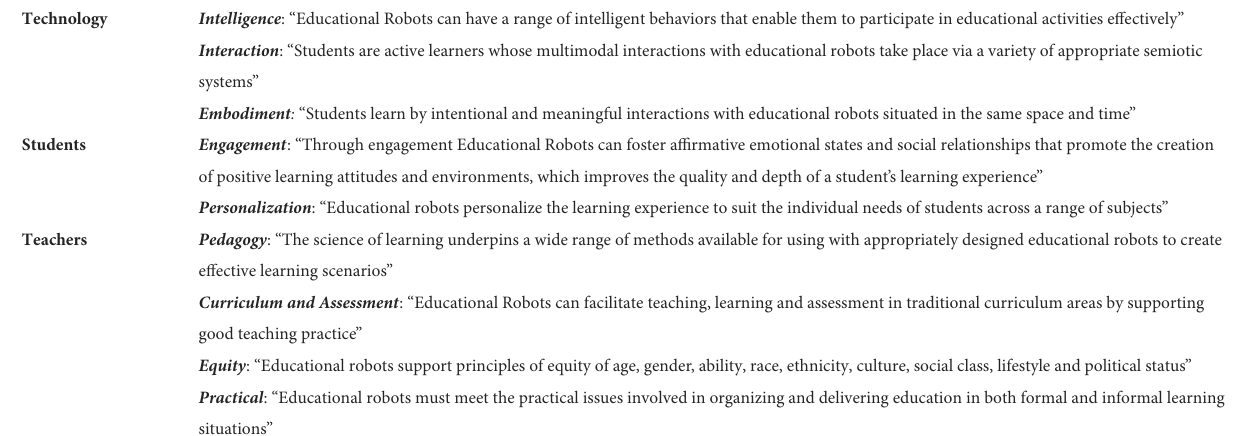
TABLE 2 Summary of the ERA principles (Catlin and Blamires, 2019, p. 306–307).